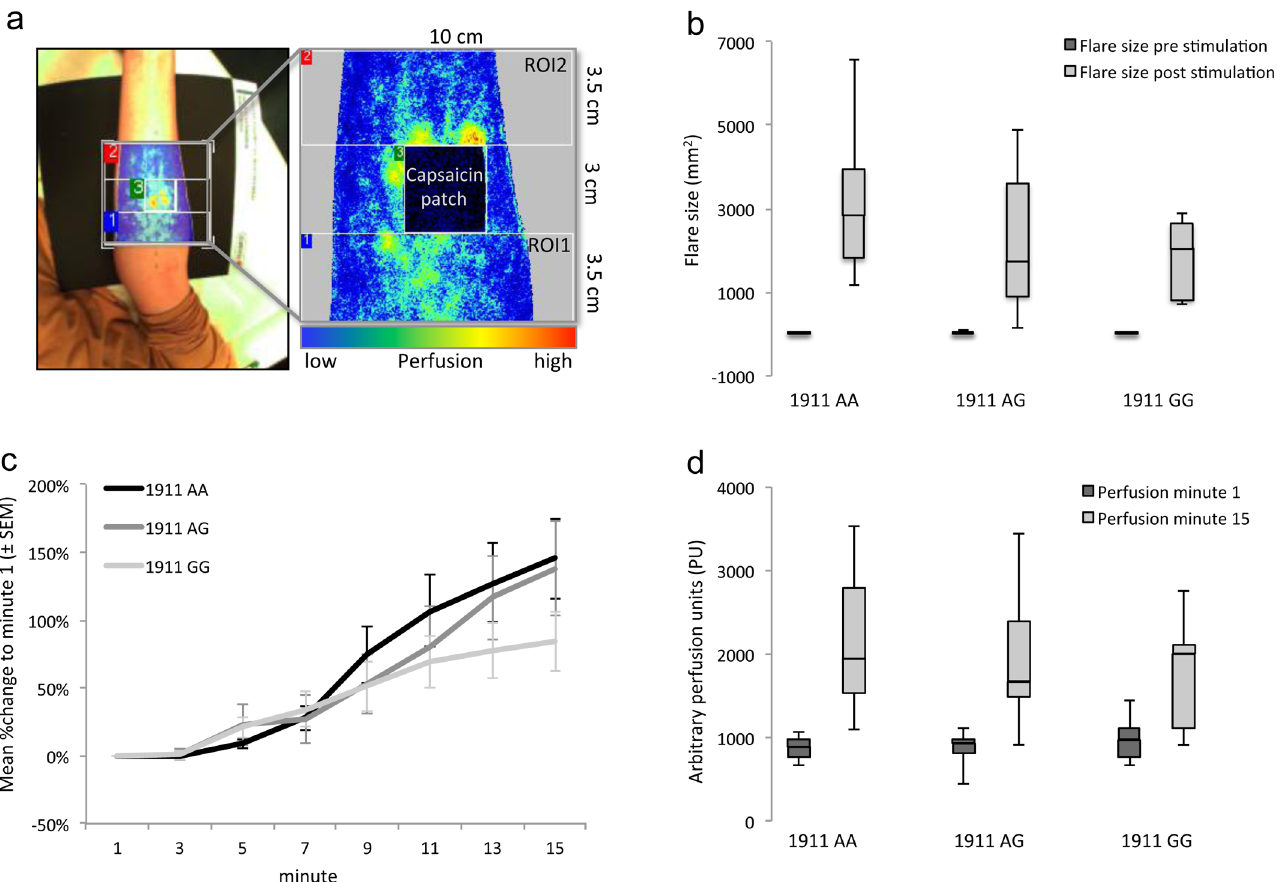
Fig 1. Laser Doppler measurement. a) Sampleimage of Laser Dopplermeasurement setup. Regionsof interest (ROI) were created aroundthe capsaicin patch stimulationarea for further calculations. The intensity image depicts the color-coded perfusionmagnitude. b) Area of elevatedskin perfusion (flare) was measuredin mm 2 . There was no significantdifference betweenthe genotypes, howevera trend towards smaller flare areas in 1911GG carriers can be observed. c-d ) Perfusion changesduringcapsaicinapplicationwere measuredvia Laser Dopplerflowmetry. There was no significantdifference betweenthe genotypes, but a trend towards a decreasedperfusion gain in 1911 GG